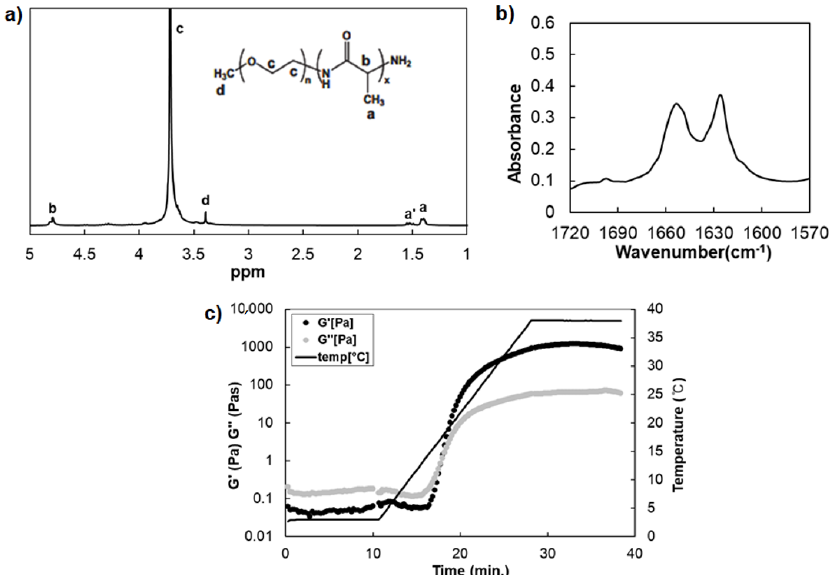
Figure 1. The characterization of mPEG-PA (P). ( a ) 1 H-NMR spectra of P (25 ◦ C in CF 3 COOD). ( b ) FTIR spectra of freeze-dried P. ( c ) Modulus of the P (12.0 wt.% in DW) as a function of temperature (4–37 ◦ C).